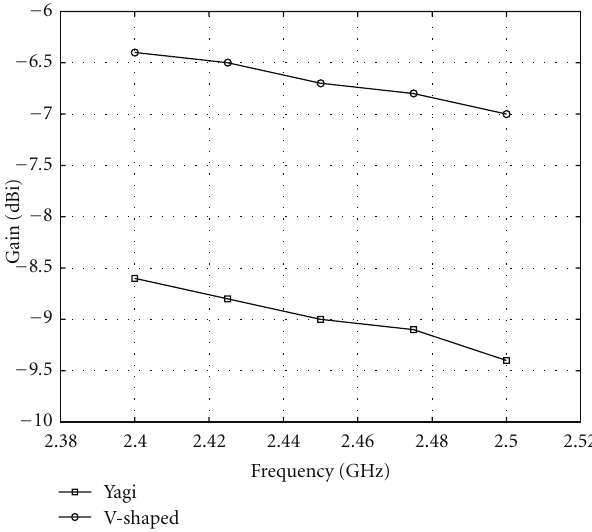
Figure 11: Simulated Gain values versus frequency for the V-shaped and Yagi arrays 5 cm over a 1 m diameter GND plane.